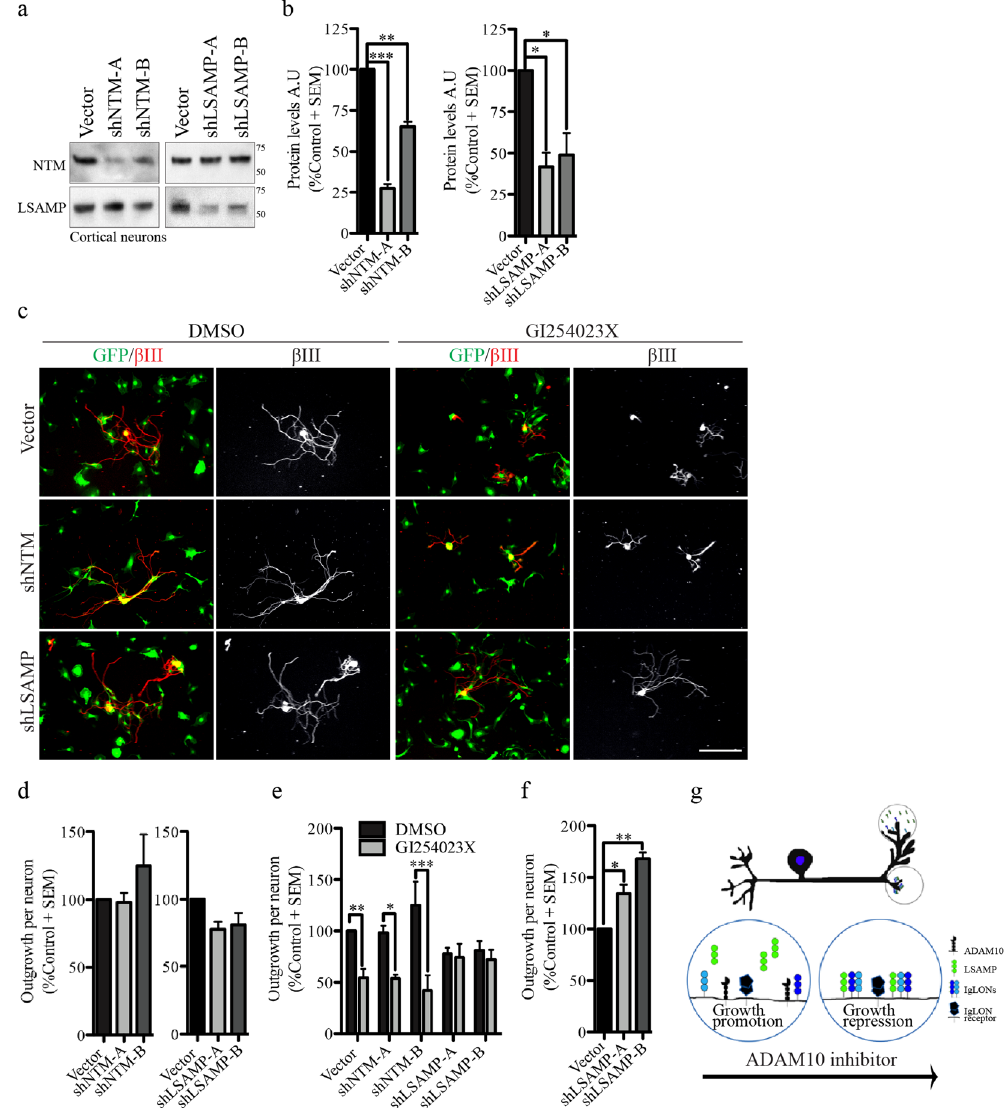
Figure 6. LSAMP loss of function desensitizes DRG neurons to an ADAM10 inhibitor. ( a ) Western Blot of conditioned media from embryonic cortical neurons expressing control lentivirus (vector), NTM-shRNAmir (shNTM-A and shNTM-B) or LSAMP-shRNAmir (shLSAMP-A and shLSAMP-B) for 8 days and treated with PI-PLC for 1 hr. Full length Western blots provided in Fig. S2a. ( b ) Densitometry analysis of NTM and LSAMP proteins present in the media after PI-PLC treatment. ( c ) β III tubulin staining of embryonic DRG (E18-19) neurons infected with control GFP-lentivirus, NTM-shRNAmir or LSAMP-shRNAmir for 8 days, reseeded on PLL coated plates and exposed to DMSO or GI254023X for 24 hrs. ( d , e ) Quantification of neurite outgrowth of reseeded embryonic DRG neurons expressing vector GFP, NTM-shRNAmir or LSAMP-shRNAmir ( d ) and exposed to DMSO or GI254023X ( e ). ( f ) Quantification of neurite outgrowth from reseeded postnatal DRG neurons expressing vector GFP or LSAMP-shRNAmir. N = 3 from independent cultures. ( g ) Schematic representation of IgLON shedding by ADAM10 activity during embryonic development and the effects of ADAM10 inhibition in neurite outgrowth. Data shown as mean + S.E.M. * p < 0.05, ** p < 0.01, *** p < 0.001 by one-way ANOVA, followed by Bonferroni post hoc test. Scale bar, 100 μ